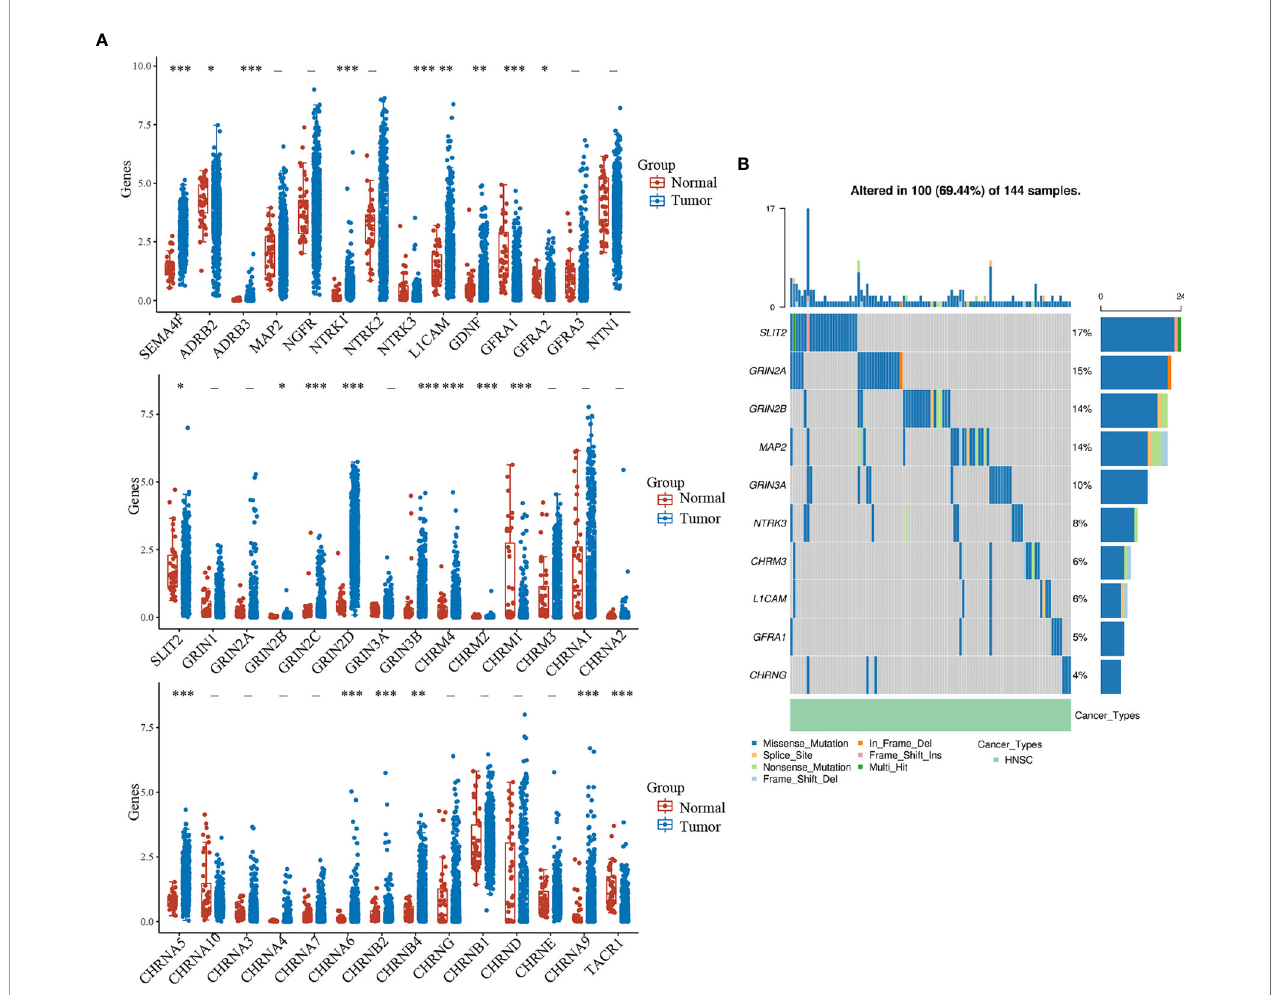
FIGURE 1 | Expression and mutation landscape of NCCGs. (A) The expression of 42 NCCGs in HNSC and normal tissue. (B) The mutation landscape of the top 10 mutation rate of NCCGs. * p < 0.05, ** p < 0.01, *** p < 0.001. NCCGs, nerve-cancer cross-talk genes; HNSC, head and neck squamous cell